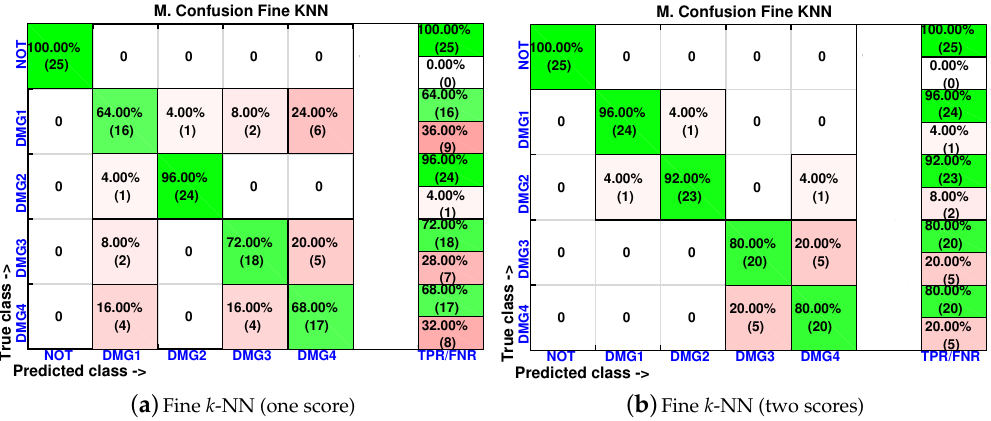
Figure 20. Confusion matrix using fine k -NN when the feature vector is formed by the first principal component ( a ) or by the first two principal components ( b ).